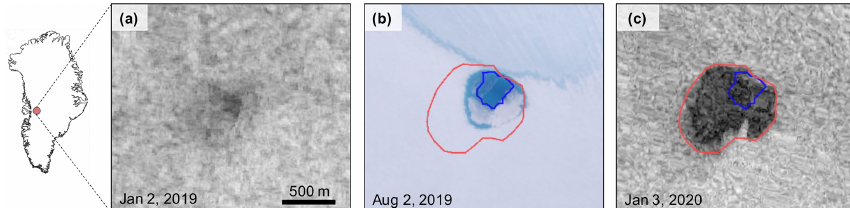
Figure 10. Chronological optical and microwave images of a buried lake in CW Greenland. (a) S1 image from 2 January 2019. (b) S2 image from 2 August 2019 with detected surface lakes outlined in blue and detected post-2019 melt season buried lakes outlined in red. (c) S1 image from 3 January